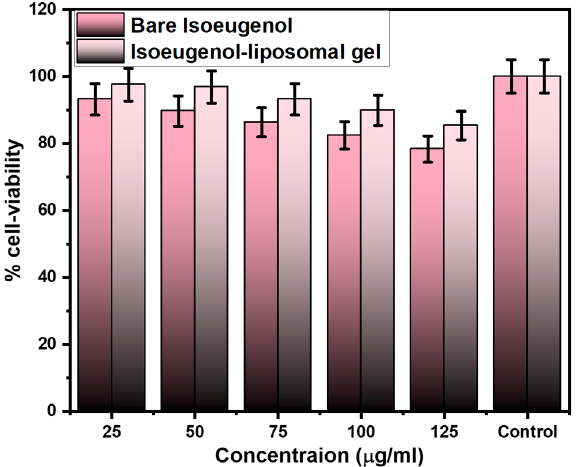
Figure 6. In vitro cell viability assay of bare isoeugenol and isoeugenol-liposomal gel against Ha- CaT